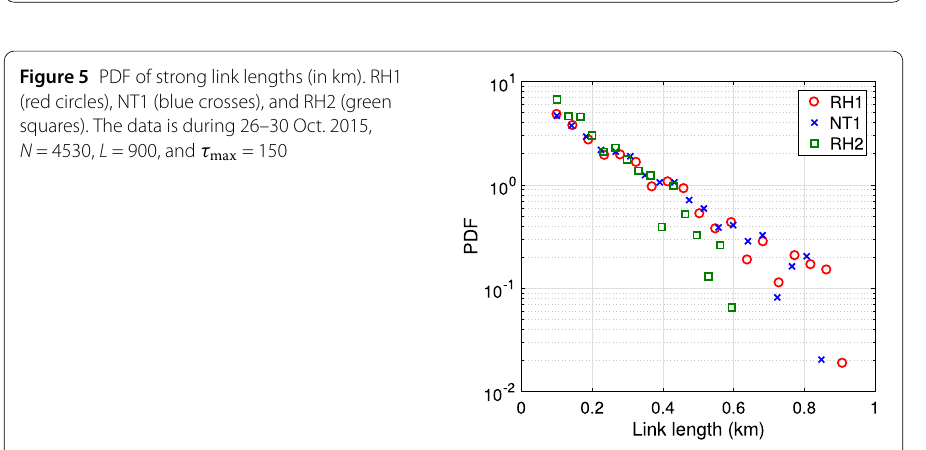
Figure 4 Statistics of weighted degree of nodes. ( a ) PDF of degree values at RH1 (red circles), NT1 (blue crosses), and RH2 (green squares). We consider links with W pos ( b ) The same as ( a ) but for the weighted degrees. ( c ) PDF of W pos i , j of the selected links in ( a ), ( b ). ( d ) Weighted degree at NT1 VS at RH1. Pearson’s correlation: 0.6538. ( e ) Weighted degree at NT1 VS at RH2. Pearson’s correlation: 0.4874. ( f ) Weighted degree at RH2 VS at RH1. Pearson’s correlation: 0.4459. The data is during 26-30 Oct. 2015, N = 4530, L = 900, and τ max = 150